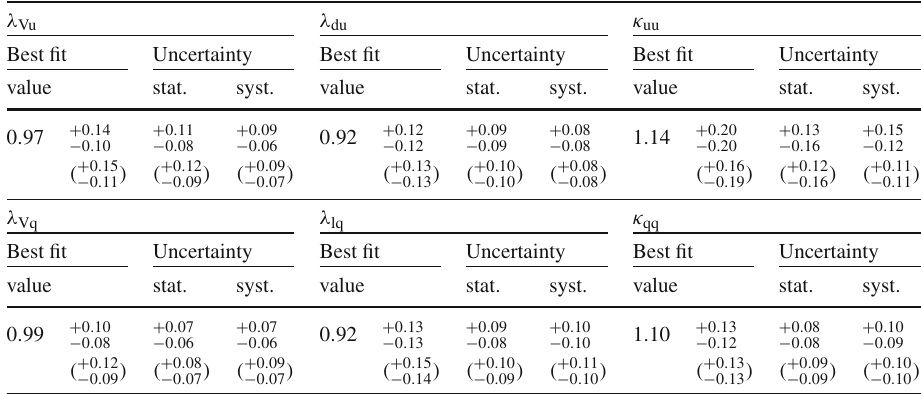
Table 11 Best fit values and ± 1 σ uncertainties for the parameters of the two benchmark models with resolved loops to test the symmetry of fermion couplings. The expected uncertainties are given in brackets